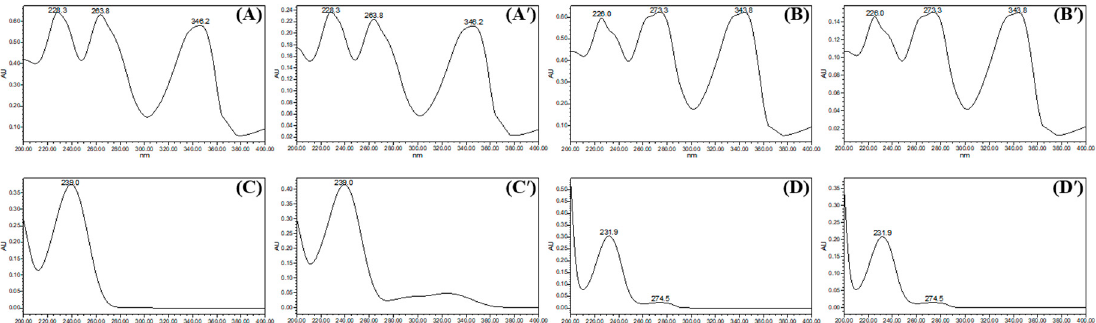
Figure 4. Photodiode array (PDA) detector spectra of the 4 reference standards ( A – D ) and of a HST extract ( A ′ – D ′ ). A , berberine; B , palmatine; C , geniposide; D , paeoniflorin.